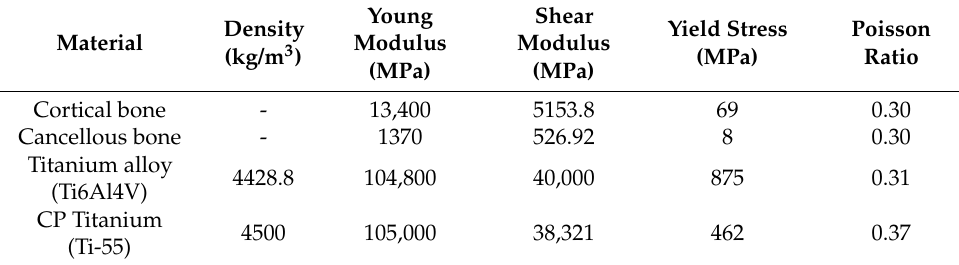
Table 2. Mechanical properties of materials [49].